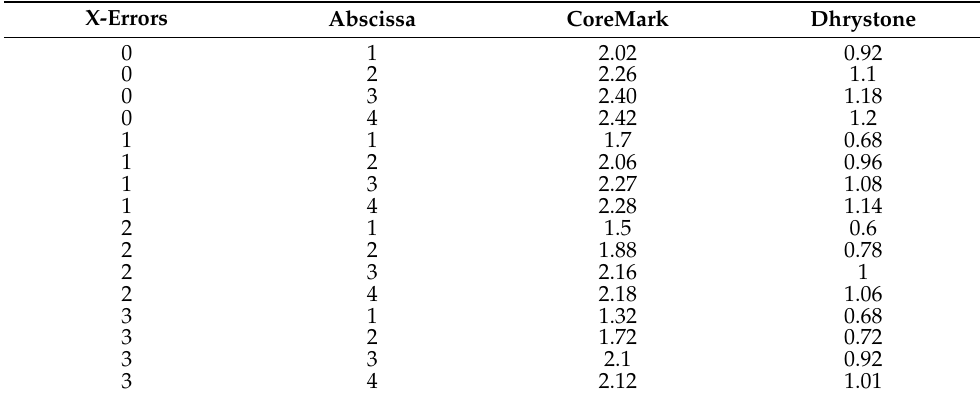
Table 1. Running results of CoreMark and Dhrystone under different error injections.